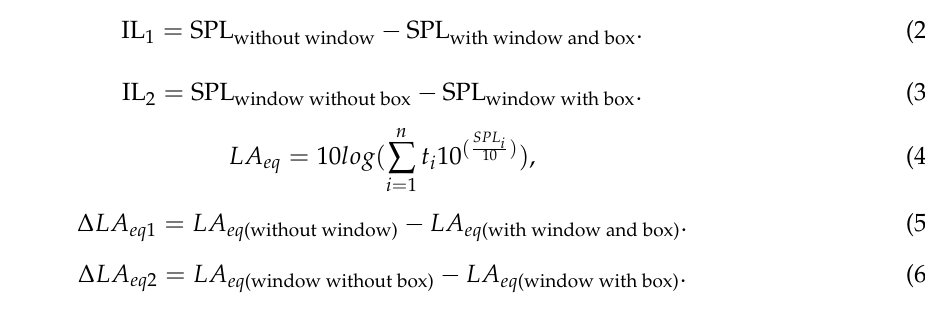
Table 2. Important details of the experiment.